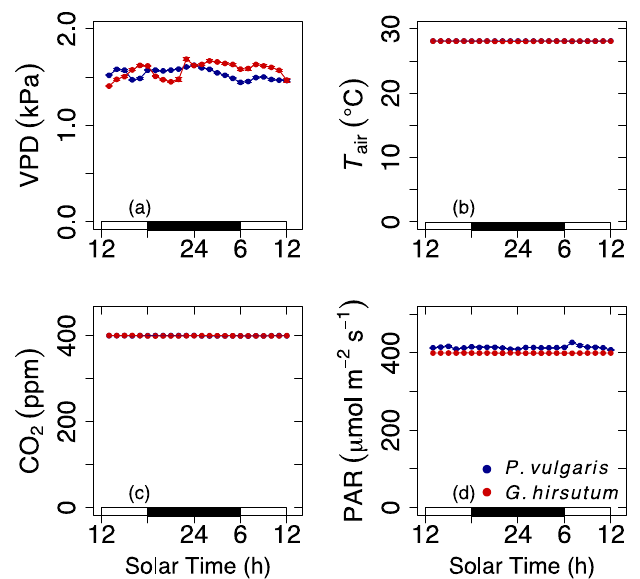
Figure 2. Environmental conditions during gas exchange measurements. The dots (with small SE bars hidden) indicate hourly averages of ( a ) vapor pressure deficit ( VPD ), ( b ) air temperature ( T air ), ( c ) CO 2 concentration, and ( d ) photosynthetically active radiation ( PAR ). Conditions in the leaf cuvette mirrored those in the macrocosms. The white and black rectangles at the base indicate the subjective day (when it would have been daytime during entrainment) and subjective night, respectively, under constant conditions. Some values may be hidden.